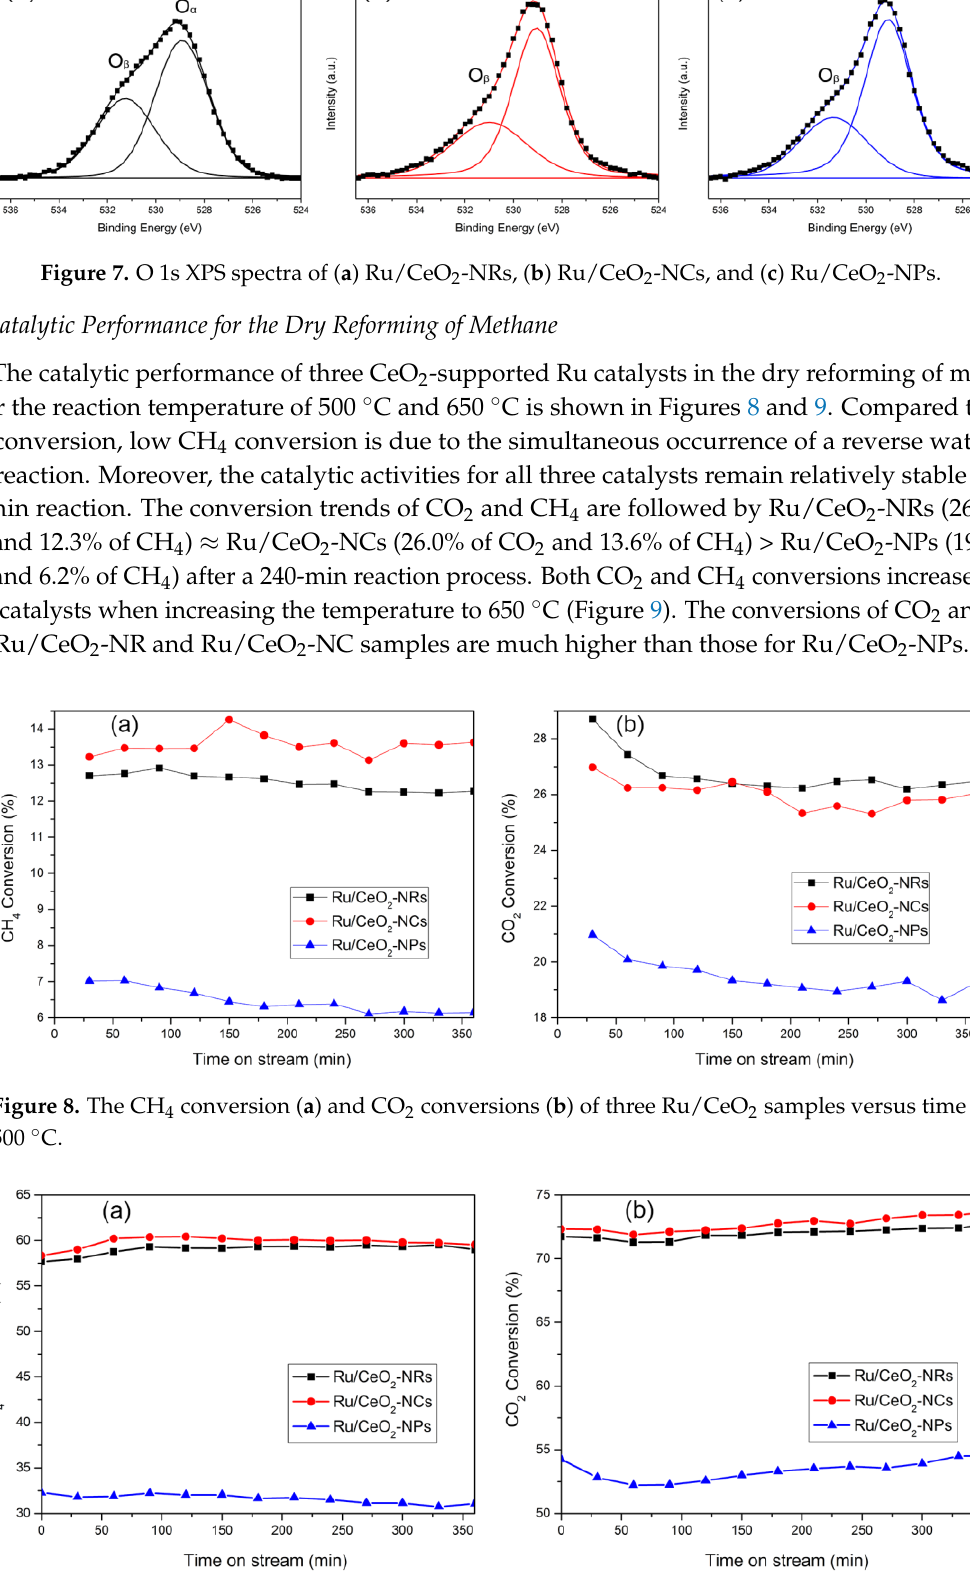
Figure 9. The CH 4 conversion ( a ) and CO 2 conversions ( b ) of three Ru/CeO 2 samples versus time at 650 °C .